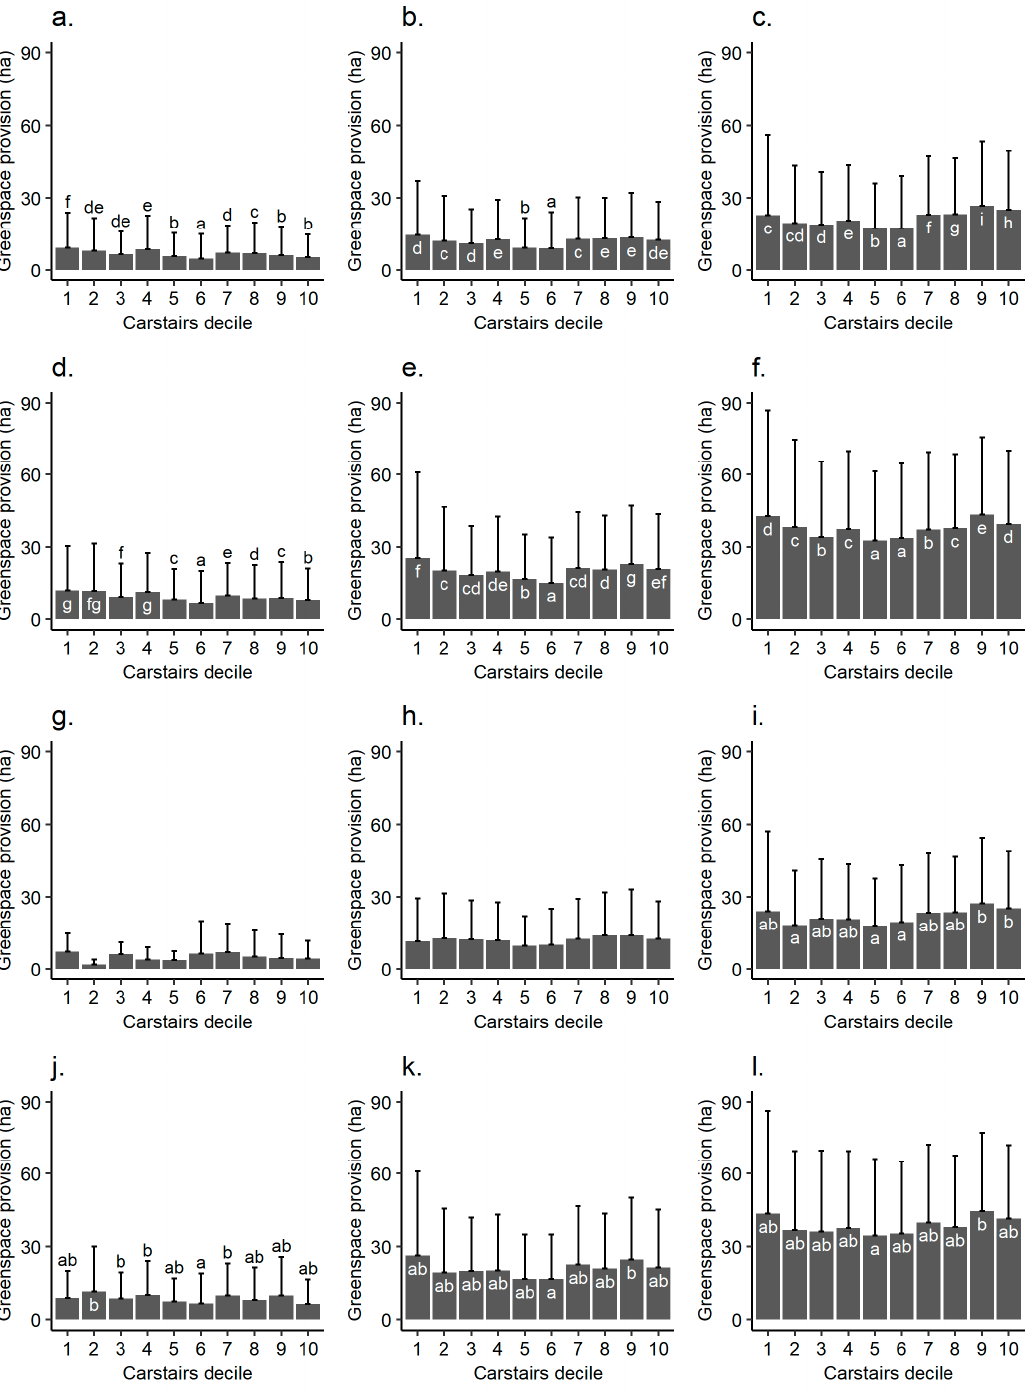
Figure 5. Variation in greenspace provision by decile of Carstairs Deprivation Index, for areas with access to at least one greenspace. Provision quantified at household scale by network analysis at 100 m (a), 300 m (b) and 500 m (c) and by straight-line buffer at 100 m (d), 300 m (e) and 500 m (f); and at Output Area scale by network analysis at 100 m (g), 300 m (h) and 500 m (i) and by straight-line buffer at 100 m (j), 300 m (k) and 500 m (l). Positive error bars show one standard deviation. Different letters indicate significant differences among deciles, e.g., ‘a’ indicates a decile that is significantly different to ‘b’ but not different to other deciles marked ‘a’; while a decile marked ‘ab’ is not significantly different to those marked either ‘a’ or ‘b’ (Tukey’s test at α = 0.05; multiple comparisons are shown only where the overall ANOVA p < 0.05 and significant differences were found).